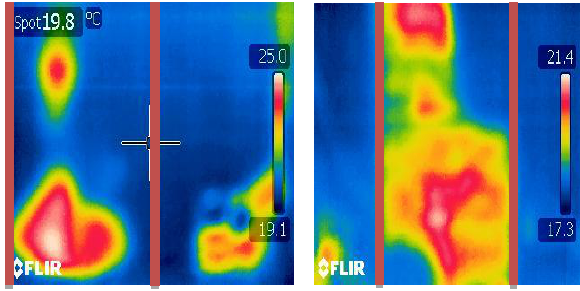
Figure 13. Alteration between bays Pour foam was then injected down the pre installed pipes in durations of 10 seconds, the pipes were withdrawn 500mm after each injection and blown through with the airline. The process of injecting alternate bays was adopted to ensure the least possible outward pressure was applied to the wall. The wall was monitored at all times for movement. It was noted that there were small areas where the pour foam leaked out while still in liquid form, these areas were plugged using expanded spray foam pieces.